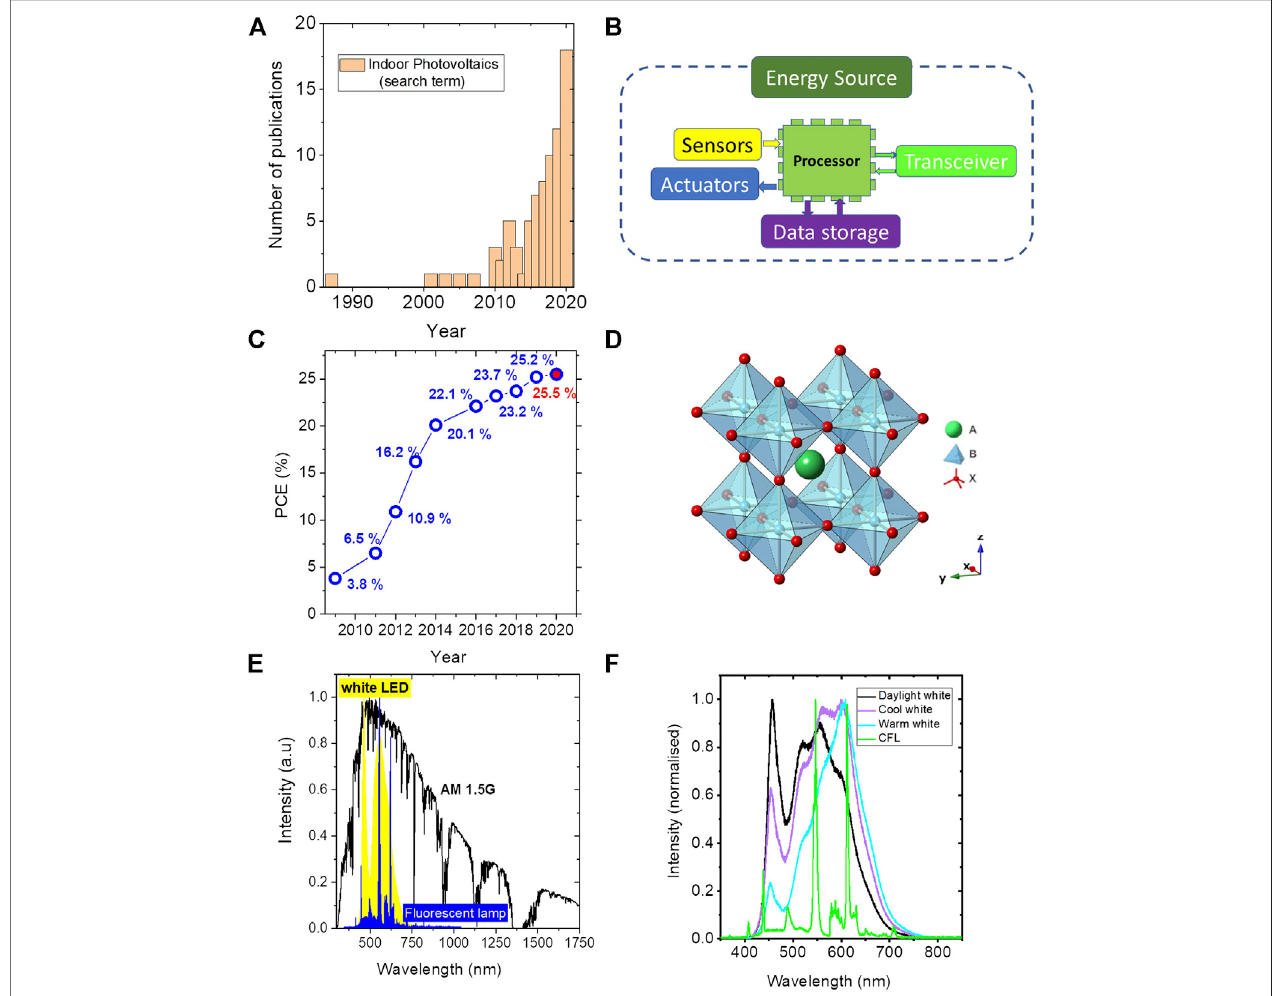
FIGURE1|(A) ThegraphshowingthenumberofIPVrelatedpublicationsasafunctionofyear. (B) ThemaincomponentsinanIoTsystem. (C) Theadvancementof PCE for hybrid perovskite solar cells over the last decade. (D) Perovskite crystal structure with cubic symmetry. Organic or inorganic cations occupy position A (green) whereasmetalcationsandhalogensoccupytheB(bluish-grey) andX(red)positions,respectively. (E) Comparisonof1Sunspectrumtoindoorarti fi ciallightspectra. (F) Spectra of different types of white LEDs and CFL lamp used inside the buildings.